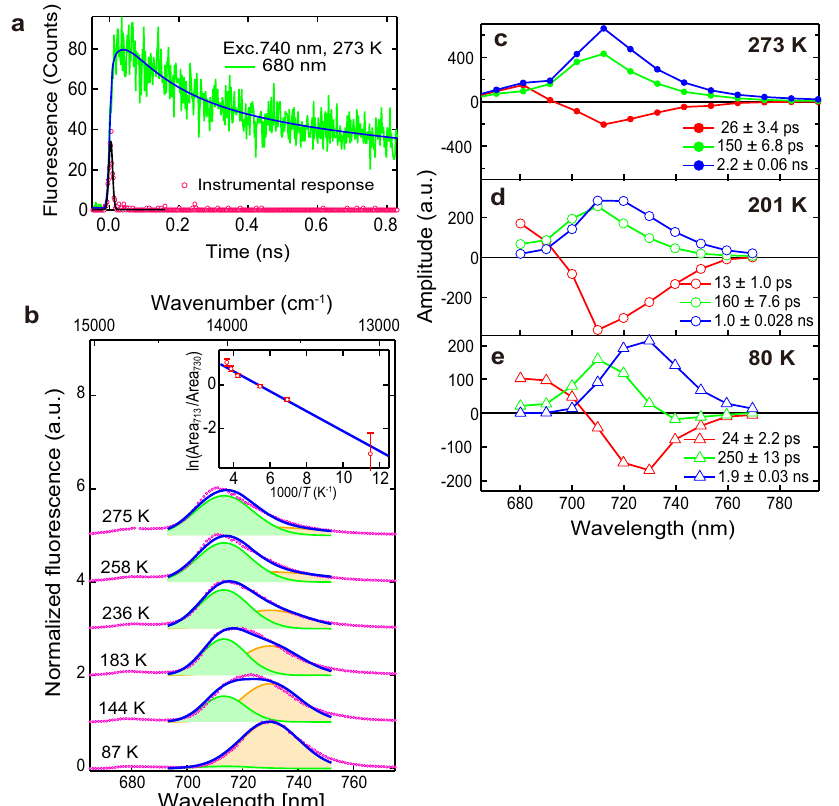
Fig. 8 | Spectroscopic analysis of Pc-frLHC. a Fluorescence time pro fi les of Pc- frLHC excited at 740nm and monitored at 680nm (green) observed at 273K. The blue line shows the fi tting curve to the sum of three exponential components convolved with the instrumental response function shown by red circles. b Temperature dependence of the fl uorescence spectrum of Pc-frLHC excited at 460nm. The blue lines are the fi tting curves to the sum of two Gaussian functions (the fi lled green and orange curves). The inset shows the analysis of the Area F713 /